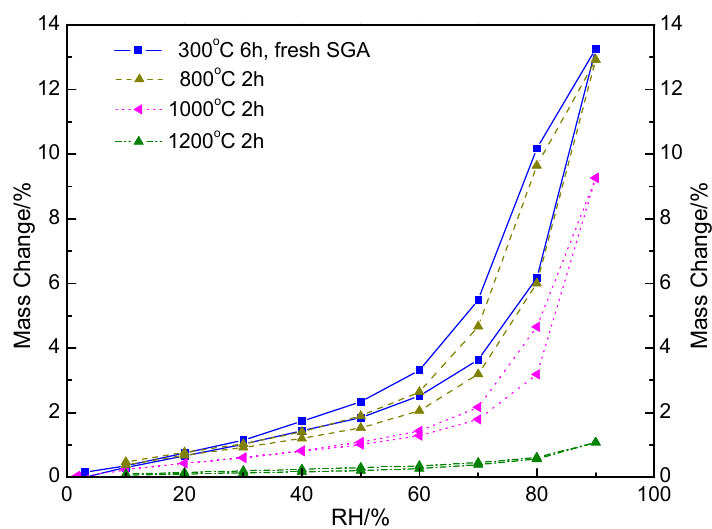
Figure 5. The water vapor adsorption isotherms of the calcined sample #1 at 800 °C, 1000 °C, and 1200 °C for 2 h.